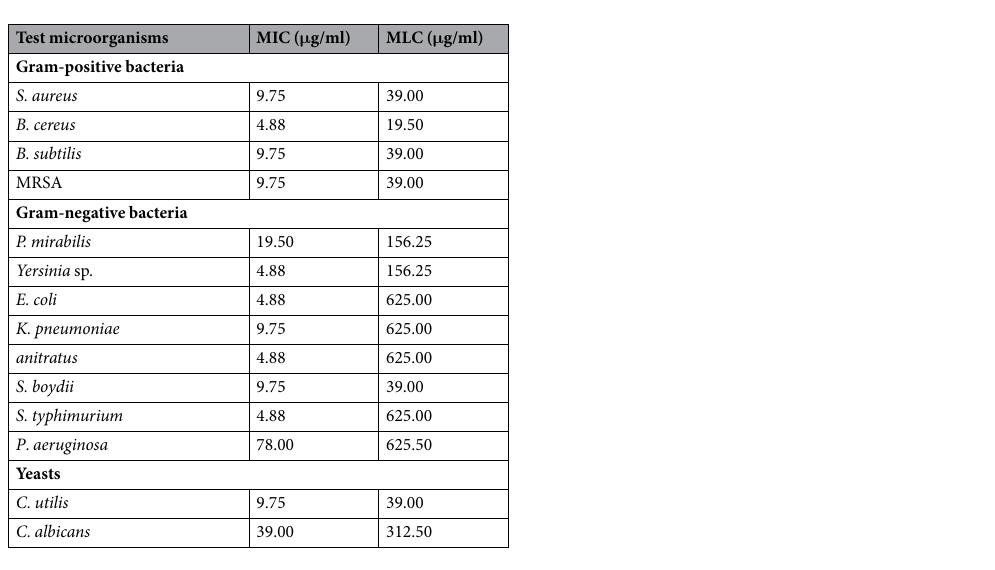
Table 3. The susceptibility of test microorganisms to H. pineodora essential oil loaded-chitosan nanoparticles on broth microdilution